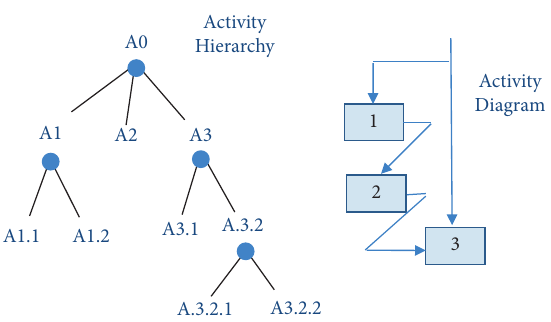
Figure 1: Activity hierarchy chart and activity diagram (OV-5)